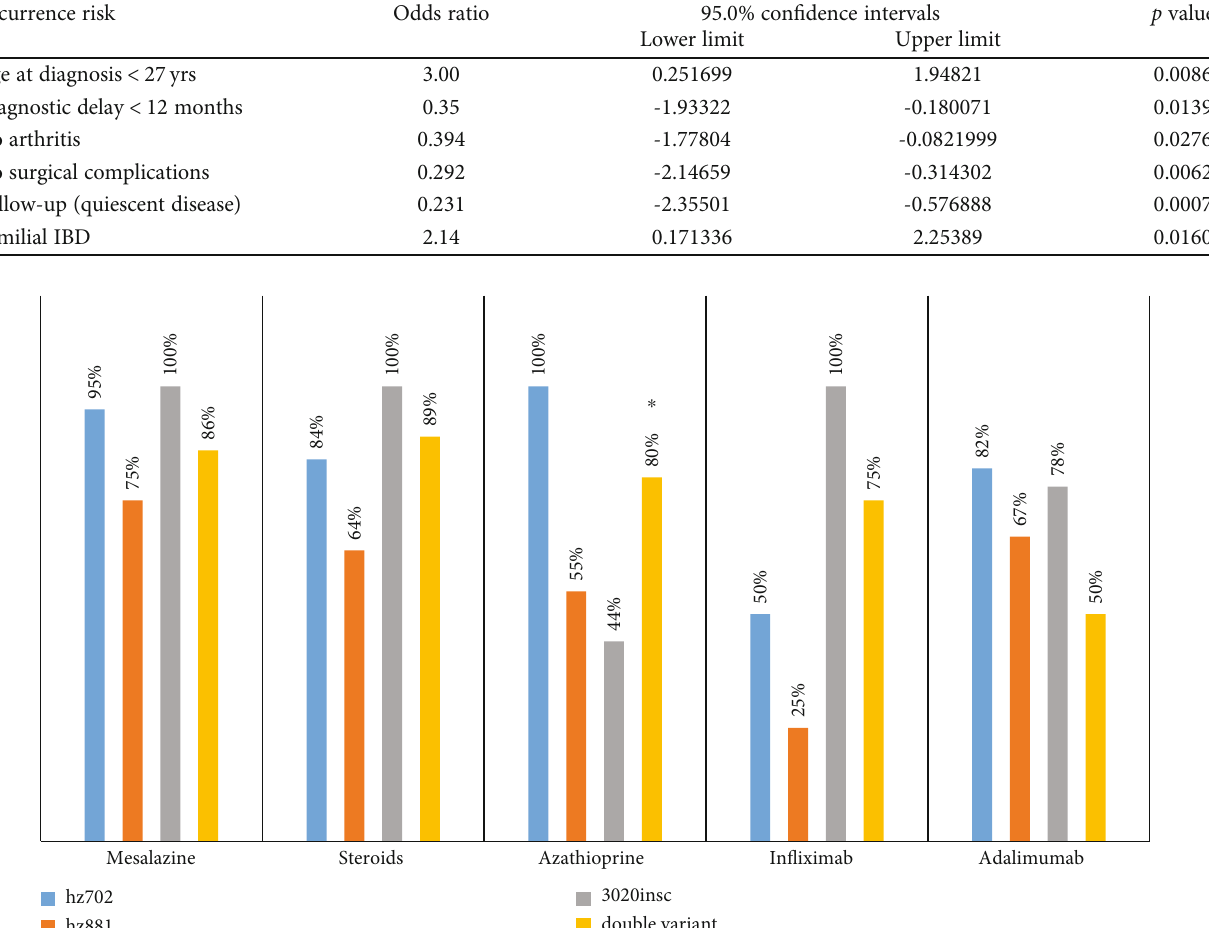
Figure 2: Medication responsiveness of polymorphism carriers. The fi gure shows the medication responsiveness of polymorphism carrier CD patients. Data are expressed as percentage. ∗ p < 0 : 05